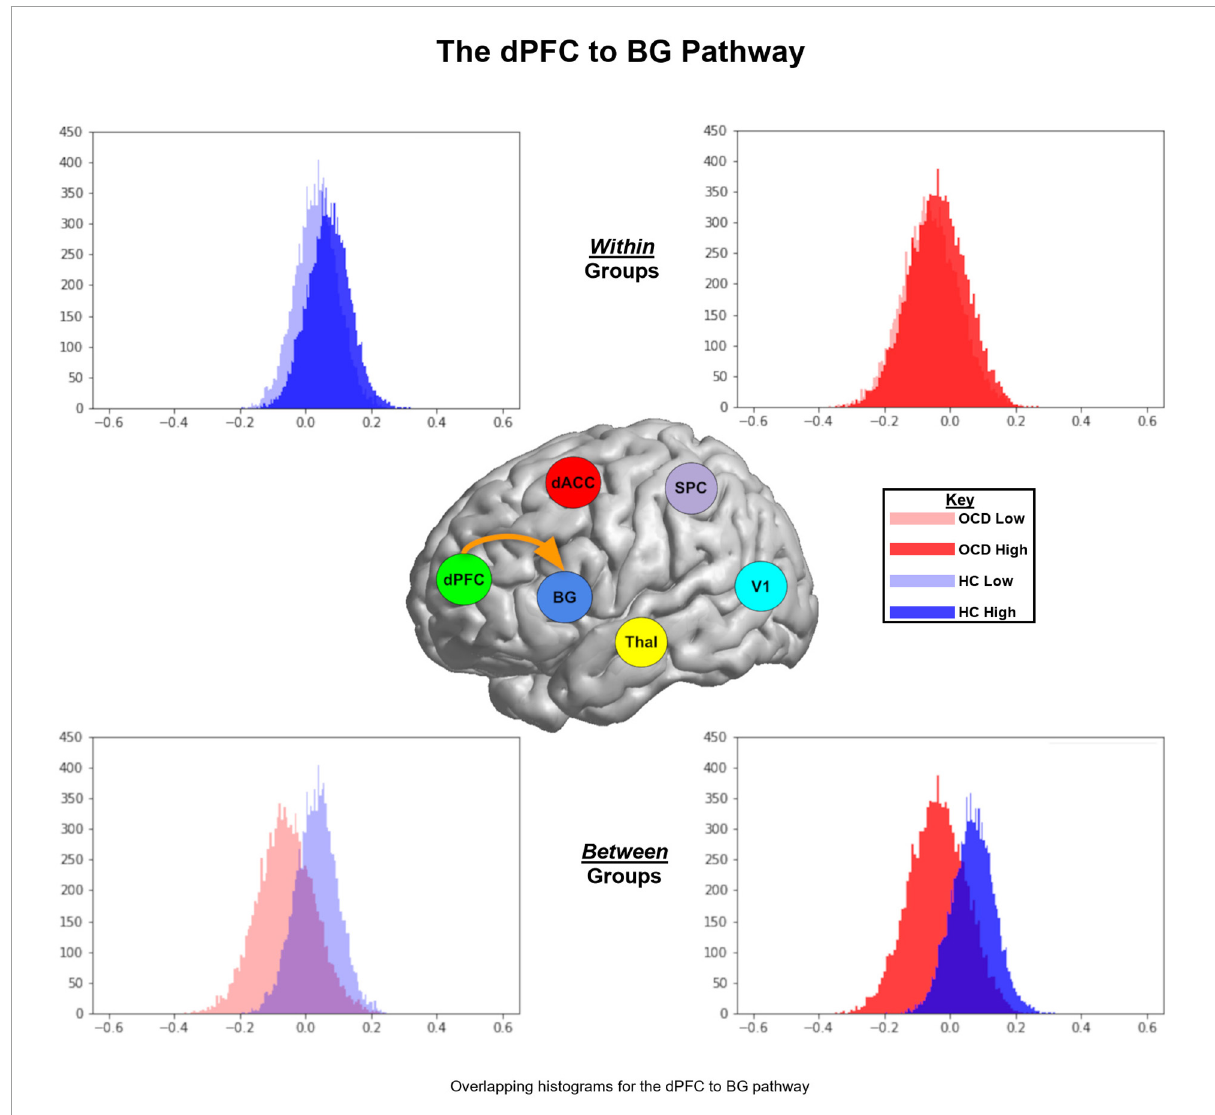
FIGURE6 Parameter histograms for the dPFC → BG pathway are presented in similar format as Figure 5 . For both low and high levels of demand, the parameter histograms for the HC group are shifted to the right of the OCD group.